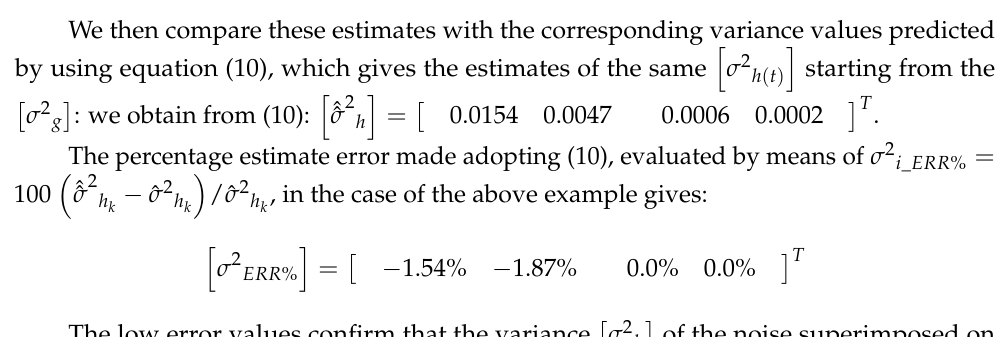
Figure 3. Correspondence between noise sequences superimposed on g ( t ) and h ( t ). Plots ( A – D ): noise sequences on g 1 ( t ) , g 2 ( t ) , g 3 ( t ) , g 4 ( t ) , respectively. Plots ( E – H ): noise sequences on h 1 ( t ) , h 2 ( t ) , h 3 ( t ) , h 4 ( t ) ,